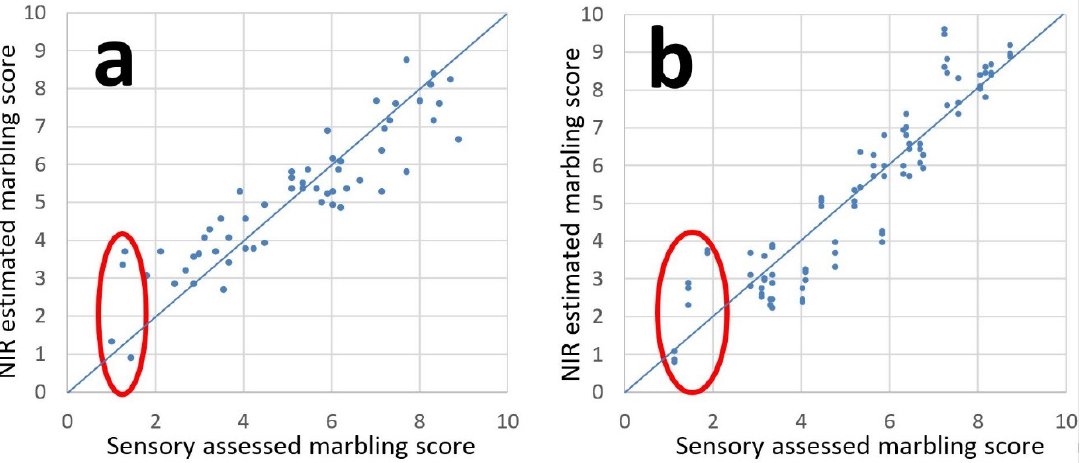
Figure 6. Predicted versus sensory assessed marbling scores in ( a ) single slices and ( b ) entire loins.